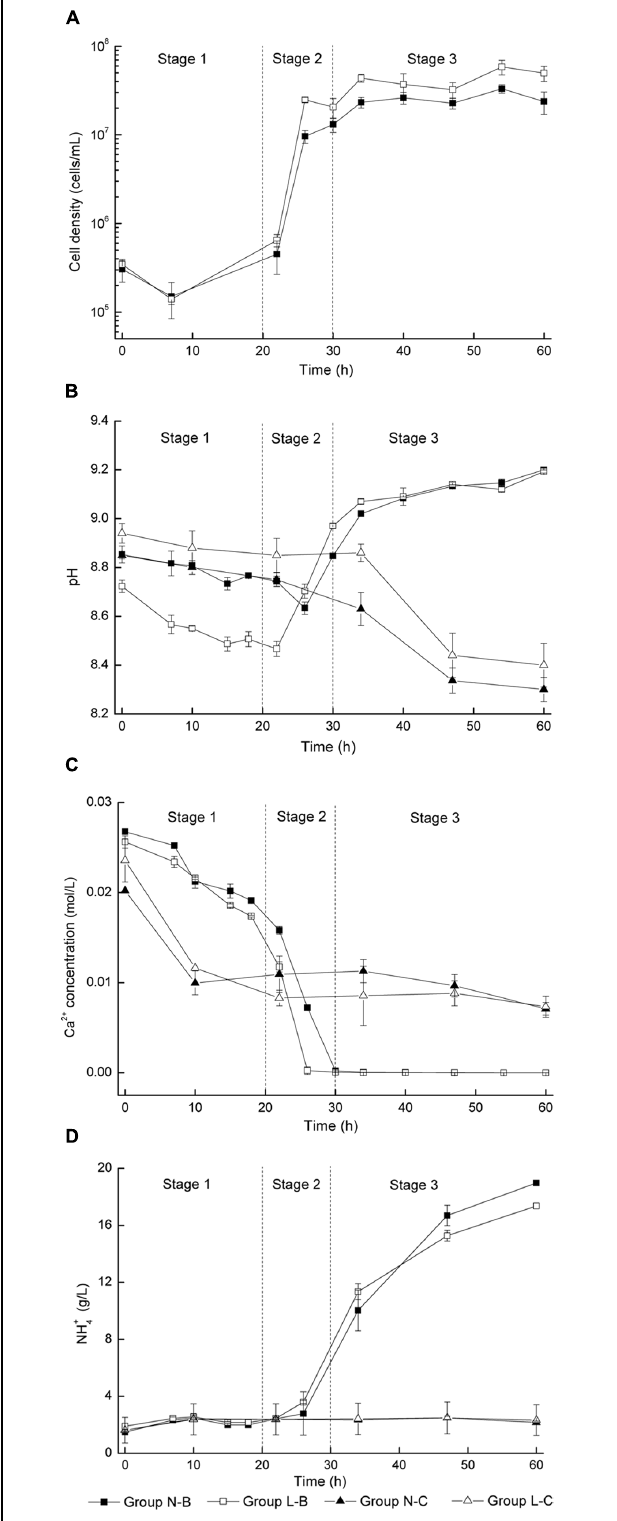
FIGURE 1 | Microbiologically induced CaCO 3 precipitation: (A) Cell density; (B) pH values; (C) Soluble Ca 2 + concentration; (D) NH 4 +